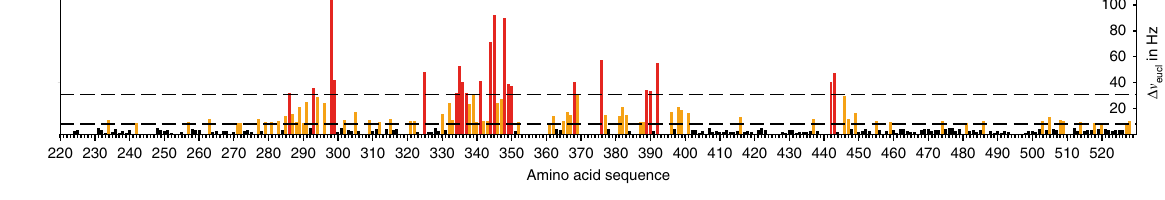
two distinct clusters of binding isotherms for NN P-dimers.